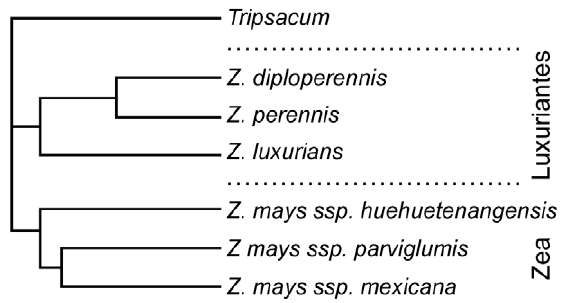
Figure 1. Simplified tree showing the likely genetic relation- ships among the teosintes when using Tripsacum as the